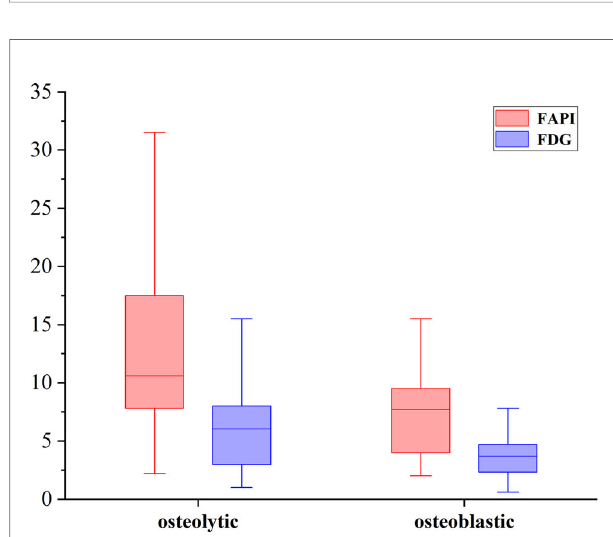
FIGURE 2 | The SUVmax of FAPI and FDG in osteolytic and osteoblastic lesions. [ 68 Ga]Ga-DOTA-FAPI-04 accumulation was signi fi cantly higher than that of [ 18 F]FDG in both osteolytic (n=66, median SUVmax, 10.6 vs 6.1; P < 0.01), and osteoblastic metastases (n=43, median SUVmax, 7.7 vs 3.7; P < 0.01).